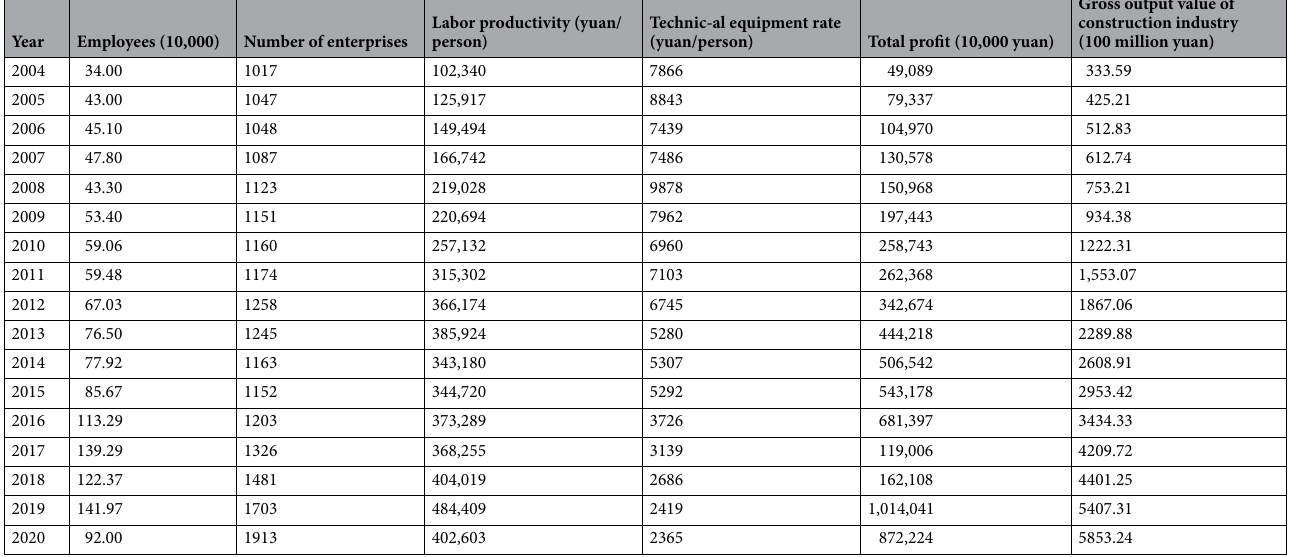
Table 2. Original data of relevant indicators of total factor productivity of Guangxi construction industry from 2004 to 2020. The labor productivity is calculated according to the gross output value.